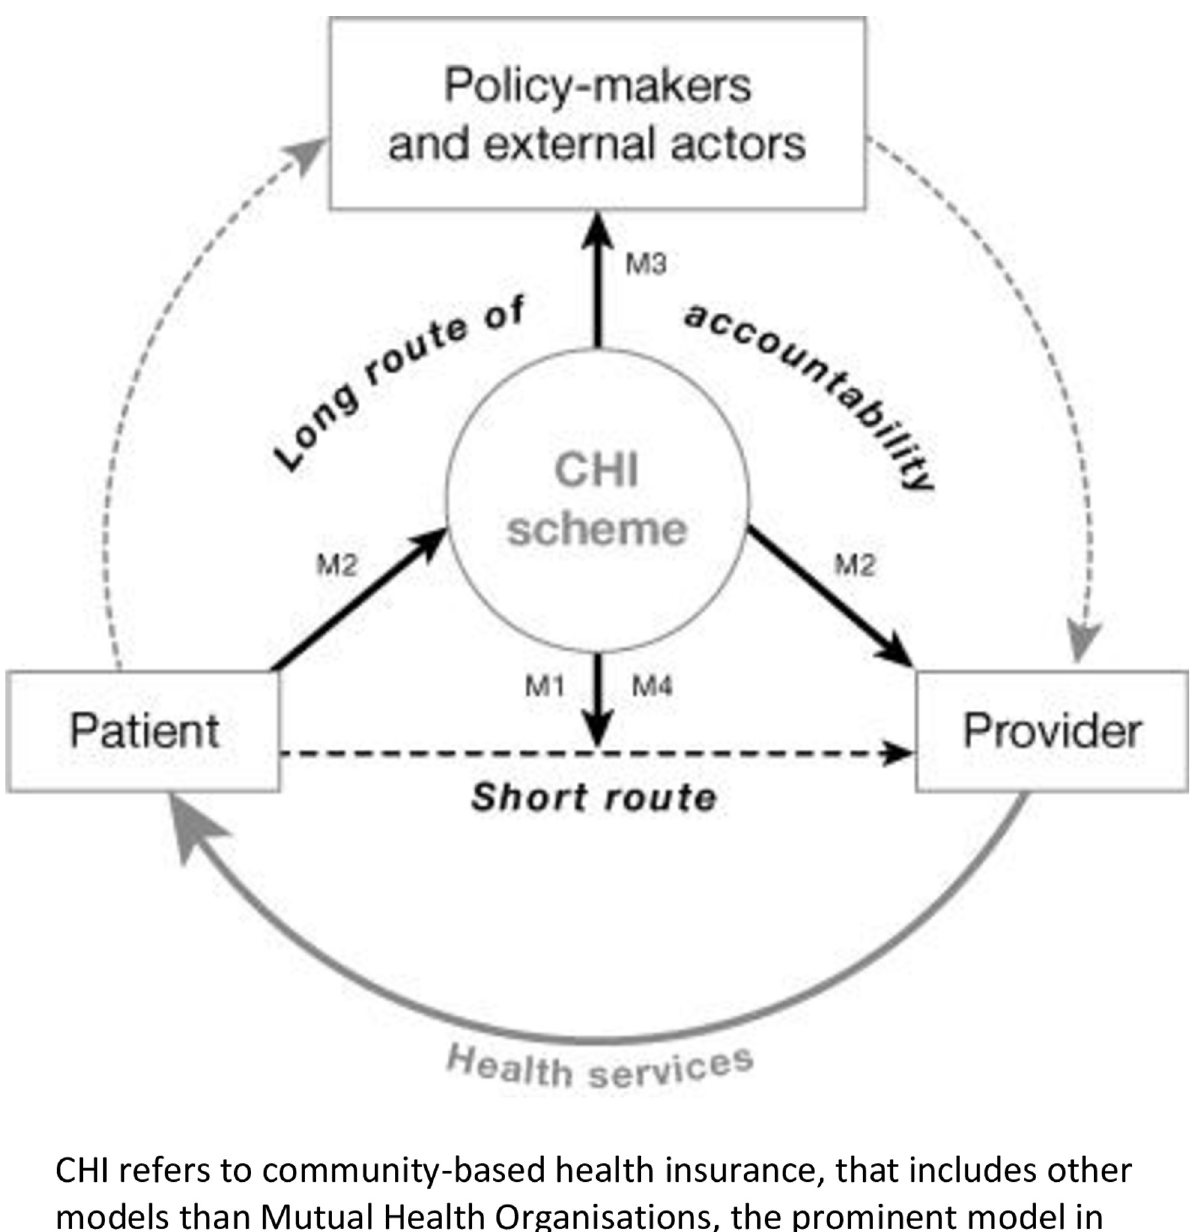
Fig 1. Explanatory framework of routes to influence care